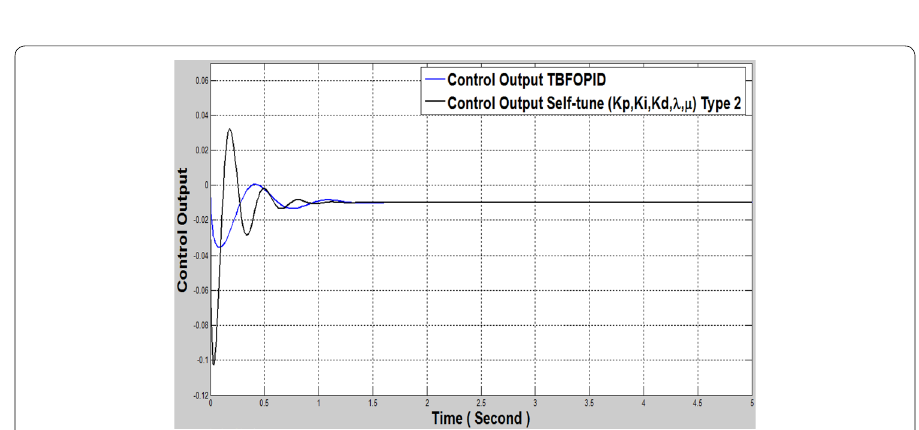
Fig. 25 Controller output via IT2FST ( k p , k i , k d , λ and μ )